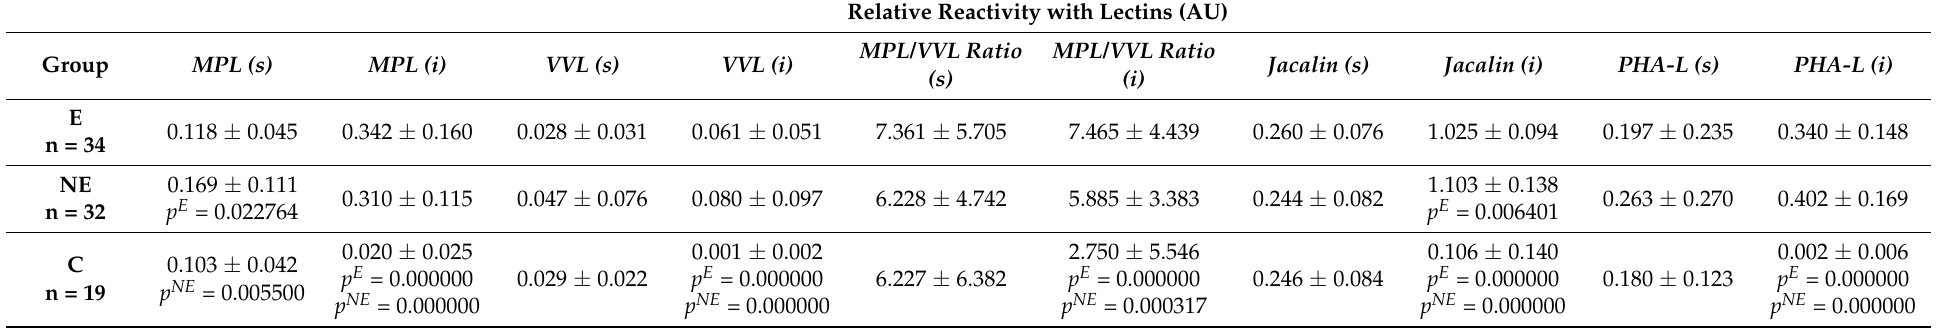
Table 1. Relative reactivities of serum native IgG and isolated serum